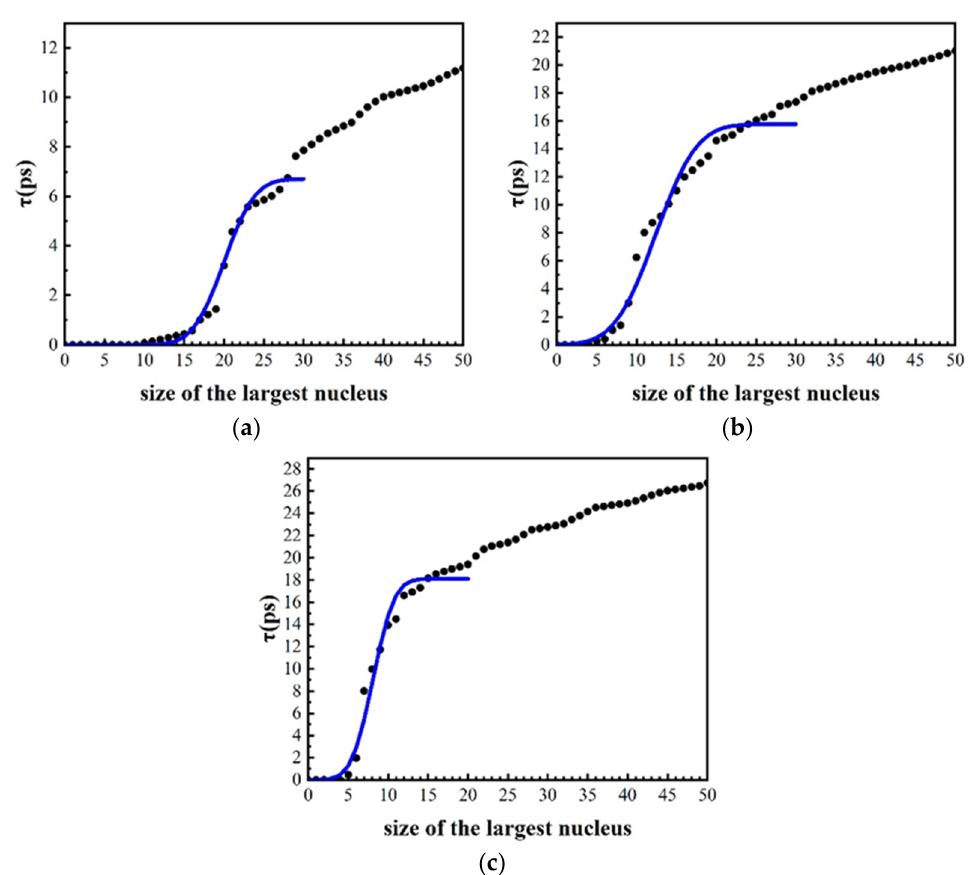
Figure 5. MFPT curves during the isothermal solidification process with different cooling rates. ( a ) 2.0 × 10 11 K/s, ( b ) 2.0 × 10 12 K/s, ( c ) 2.0 × 10 13 K/s. ( a ) 2.0 × 10 11 K/s, ( b ) 2.0 × 10 12 K/s, ( c ) 2.0 × 10 13